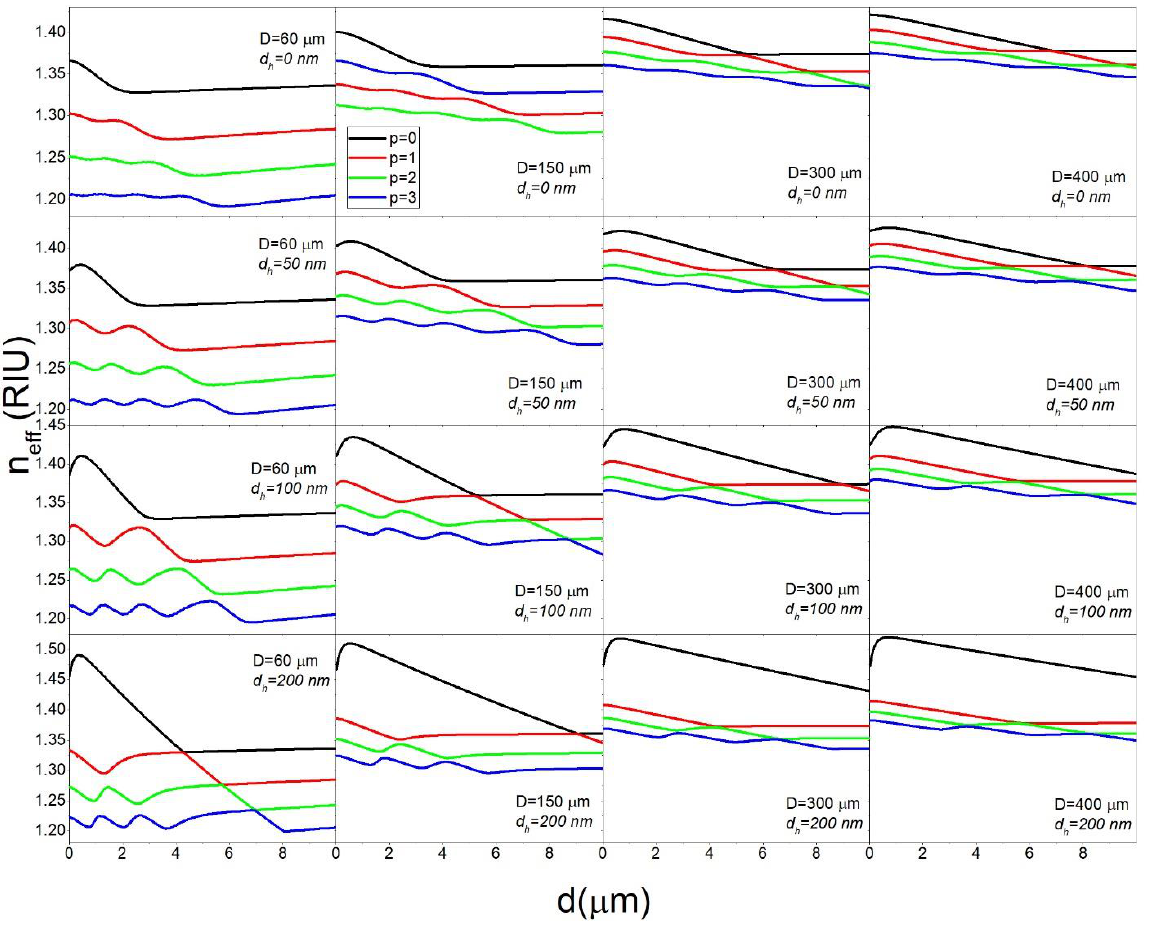
Figure 7. The dependence of n eff on d for n c = 1.4 and n h = 1.9 calculated for select values of p , d h and D .